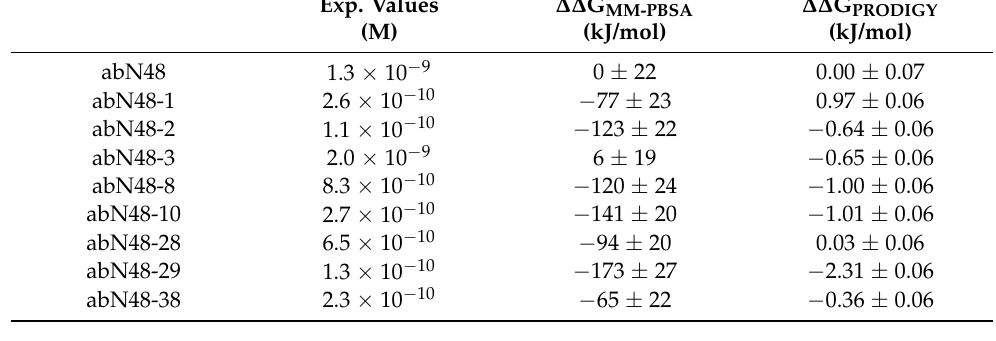
Table 2. Comparison between the ∆∆ Gs evaluated with the MM-PBSA method or PRODIGY web server and the experimental values of the K D . Exp. Values